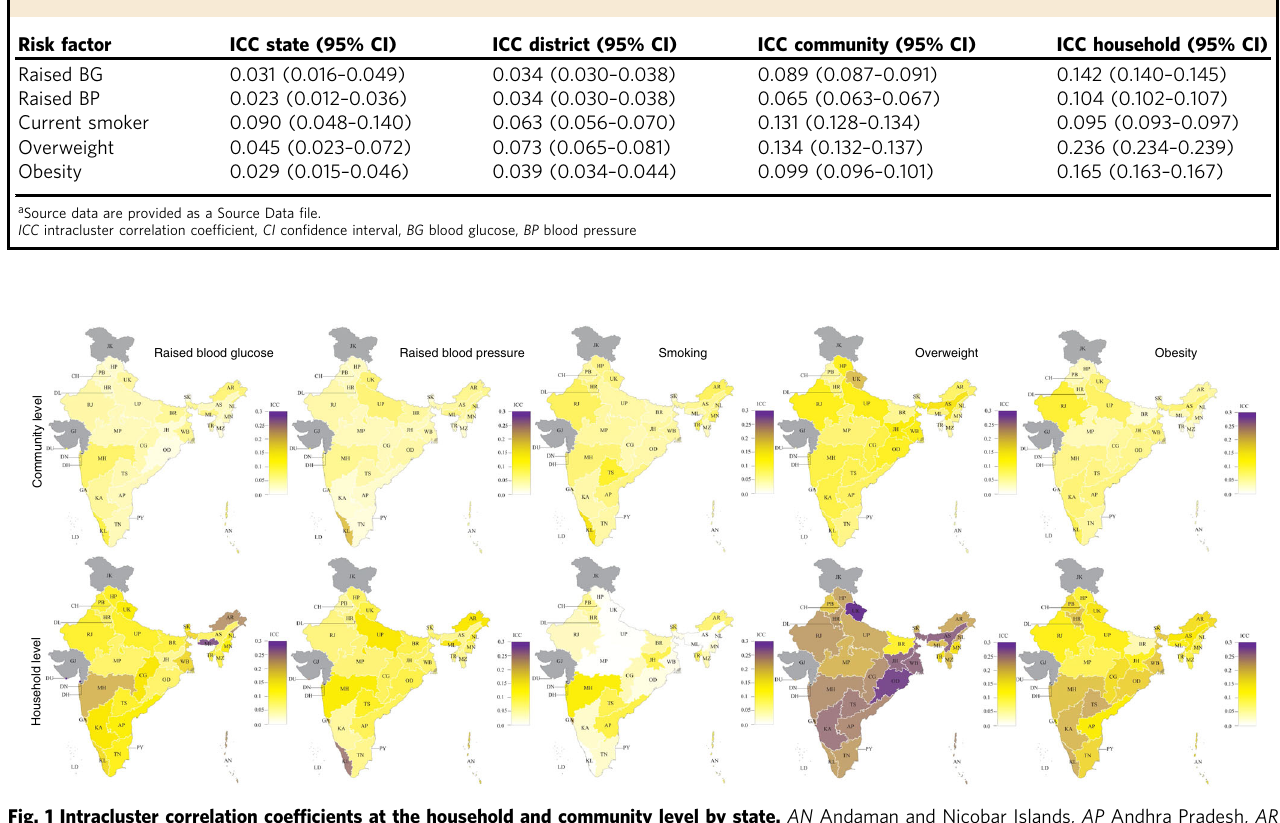
Table 3 Clustering of cardiovascular disease risk factors at the state, district, community, and household level in India a .